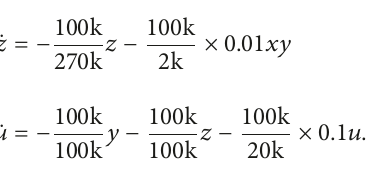
−100 k 100 k ̇𝑧 = 𝑧 − × 0.01𝑥𝑦 Then, a novel fourth-order hyperchaotic system is 270 k 2 k